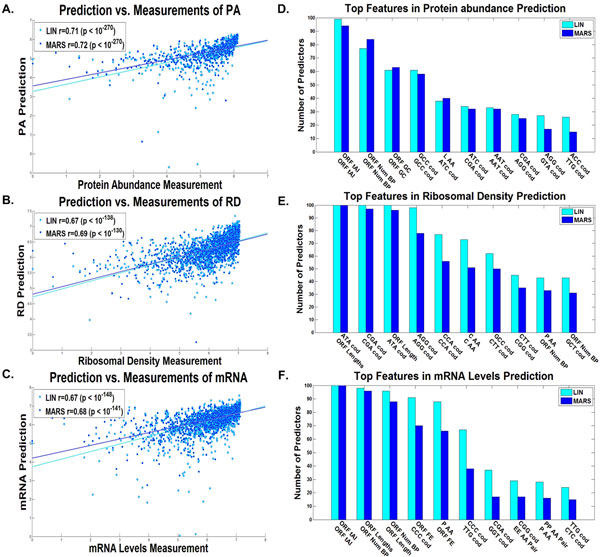
ORF linear and non-linear predictors results. Dot plot of the predictions vs. measurements for the validation set of the predictor with the median results for the A. protein levels, B. ribosomal densities, C. mRNA levels, for the ORF linear (LIN) and non-linear (MARS) predictors (Additional file 1: Supplementary Methods). The best features according to the number of predictors they participated in (Additional file 1: Supplementary Methods) of the D. protein levels predictor, E. ribosomal density predictor, and F. mRNA levels predictor, for the ORF linear (LIN) and non-linear (MARS) predictors (Additional file 1: Supplementary Methods).